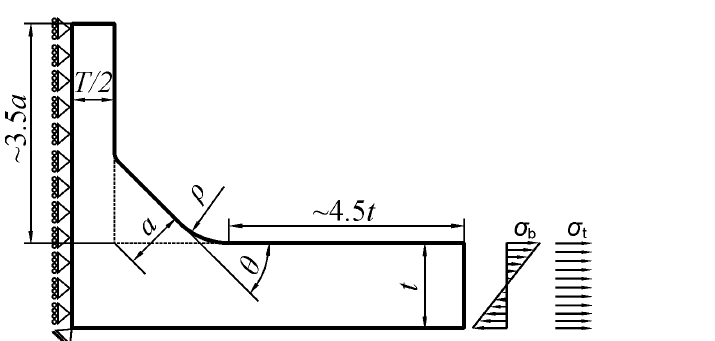
Figure 2. Basic geometrical parameters and boundary conditions of the numerical FEM model for tensile and bending loads.